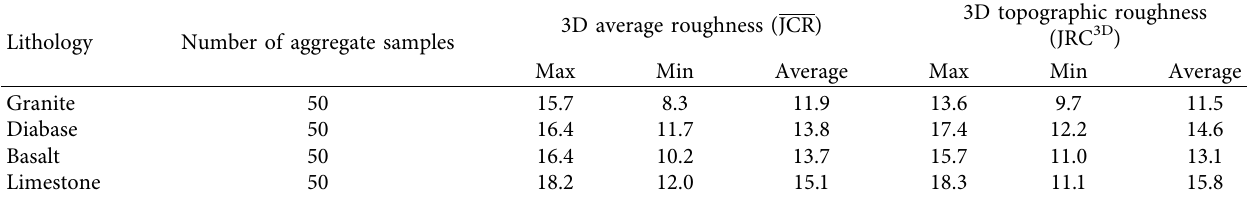
Table 8: The basic properties of